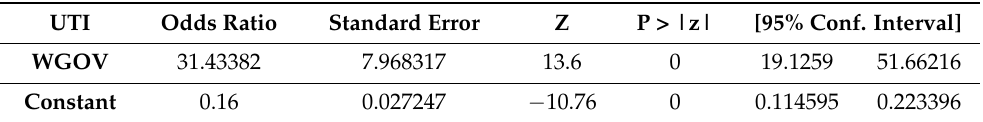
Table 6. Logistic regression a and Odds Ratio of the effects of weak governance (WGOV) on people’s Unwillingness to invest (UTI) for urban ecosystem